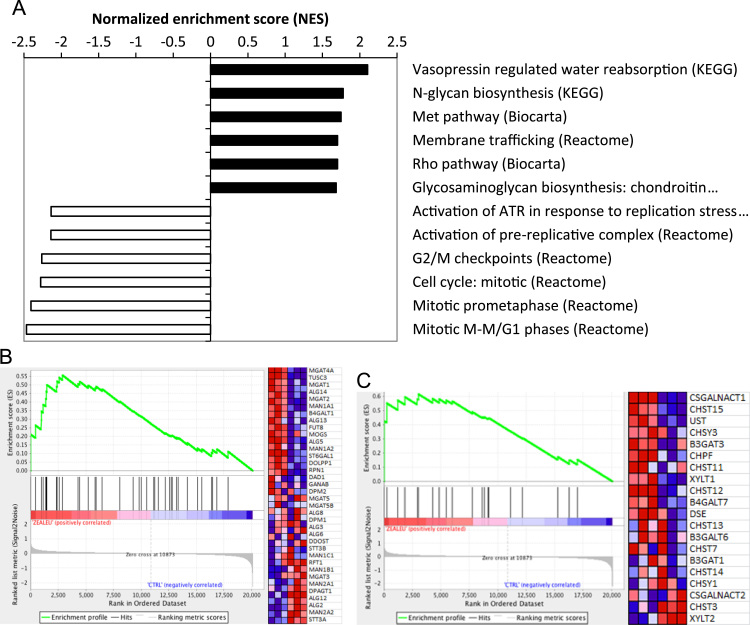
(A) Top 12 pathways identified by GSEA as upregulated or downregulated by xanthophyll treatment based on NES. Closed bars represent pathways with the highest positive NES values, and open bars represent pathways with the lowest negative NES values. Most notable are the upregulated pathways for (B) N-glycan synthesis and (C) glycosaminoglycan biosynthesis: chrondroitin sulfate. These two gene sets are shown along with a corresponding heat map in the three control and three xanthophyll sample.